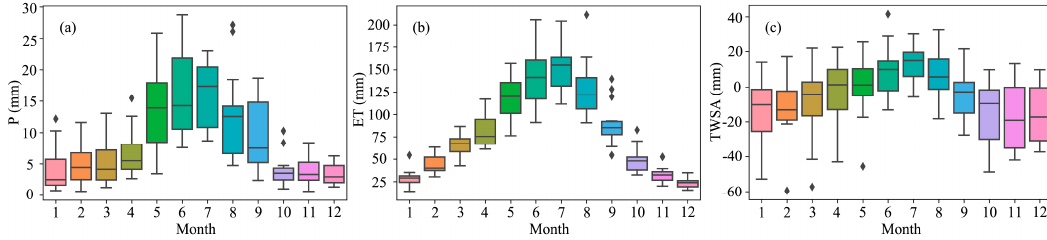
Figure 7. The mean monthly ( a ) P, ( b ) ET, and ( c ) TWSA during the period 2003–2016 in the TRB.